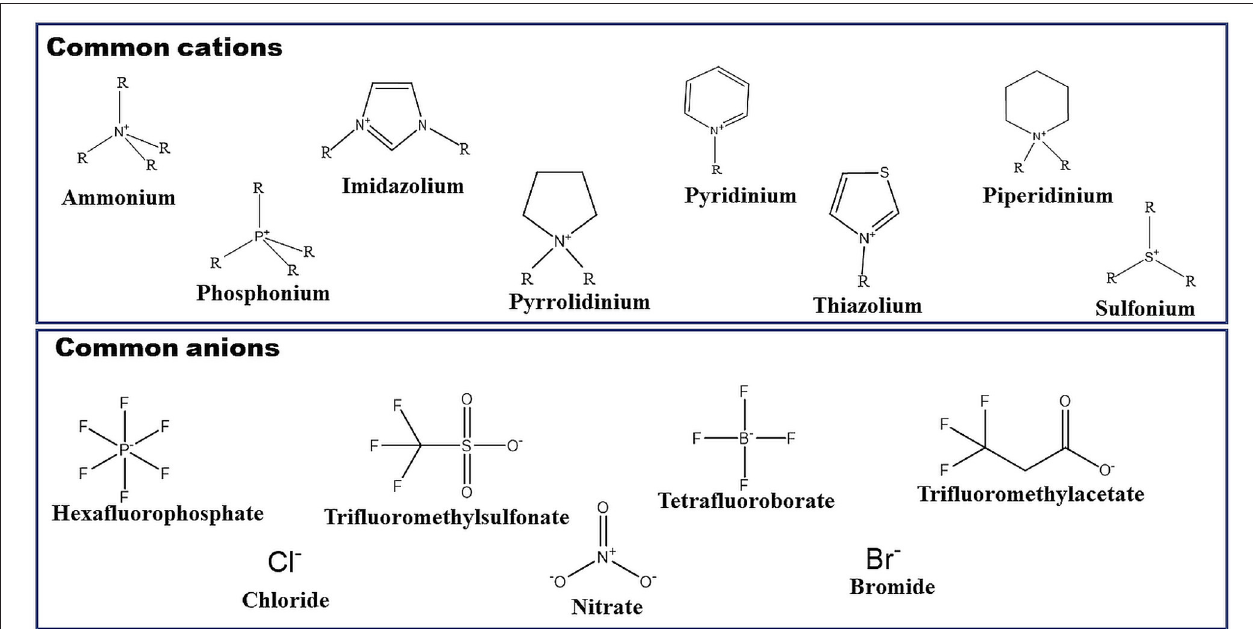
FIGURE 1 | Common cations and anions for the synthesis of ionic liquids